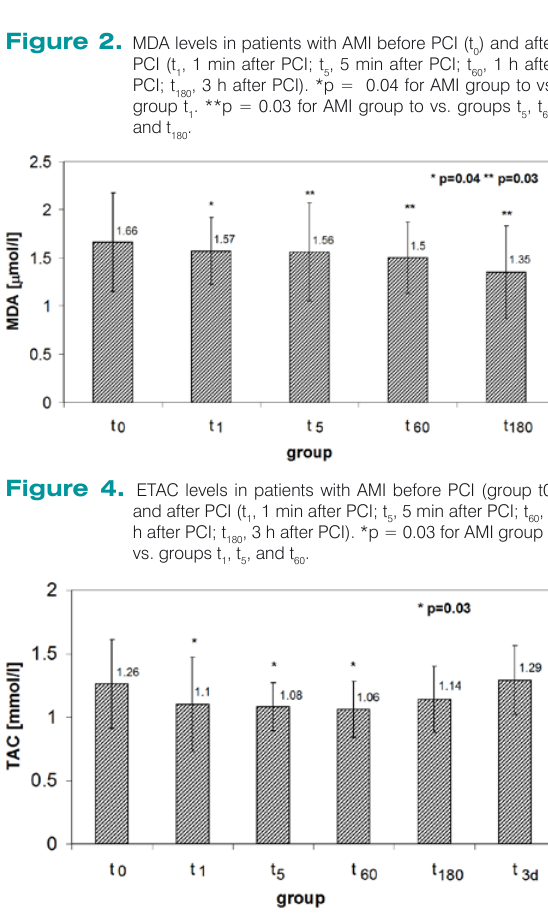
Figure 1. MDA levels in the control group and in patients with AMI